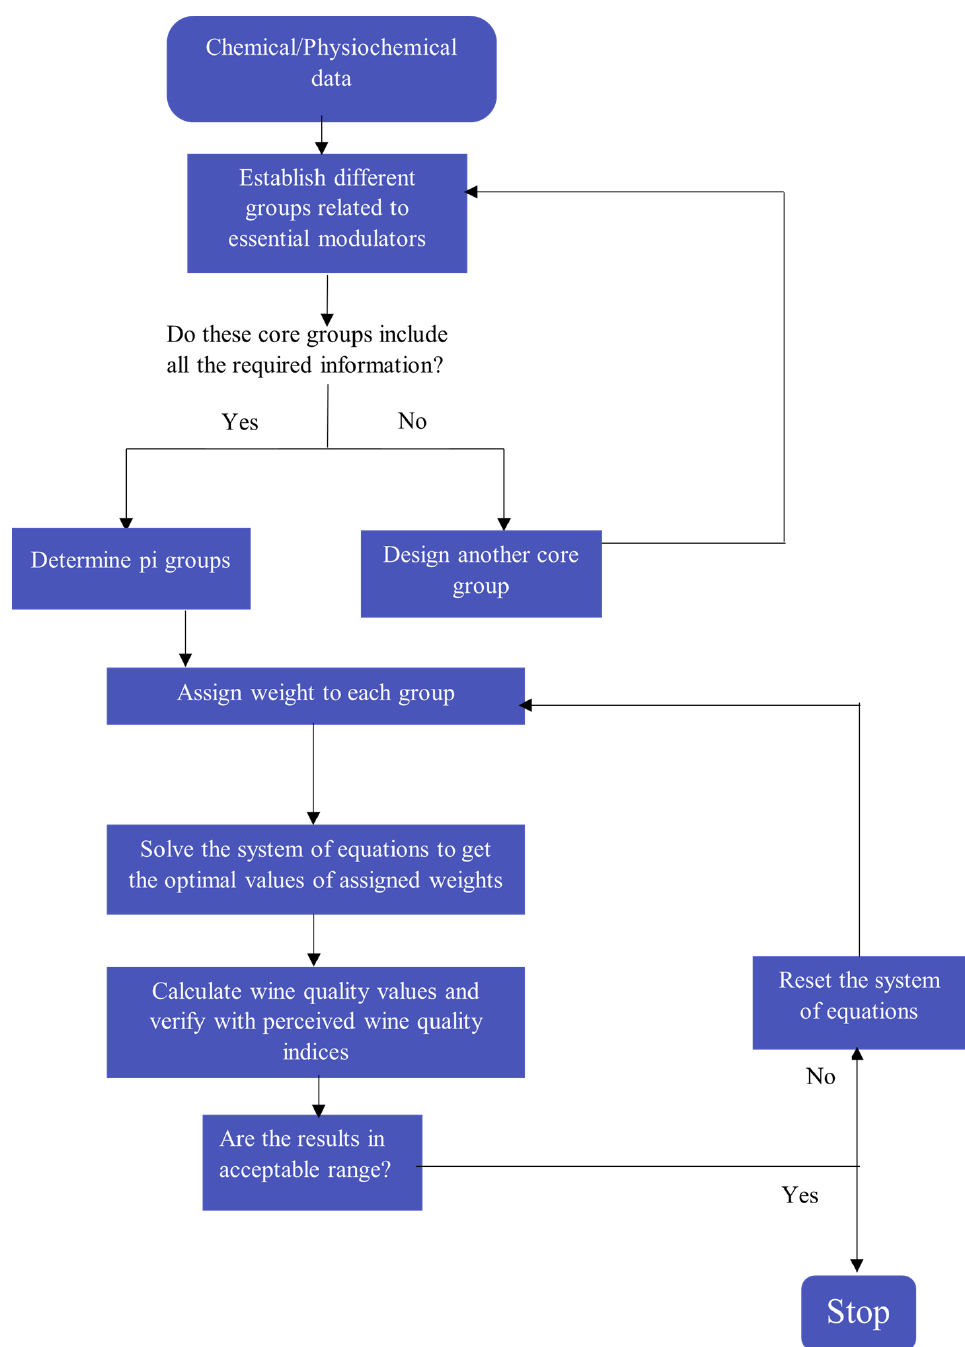
Figure 1. Flow chart for selecting essential modulators for mathematical development of the model.